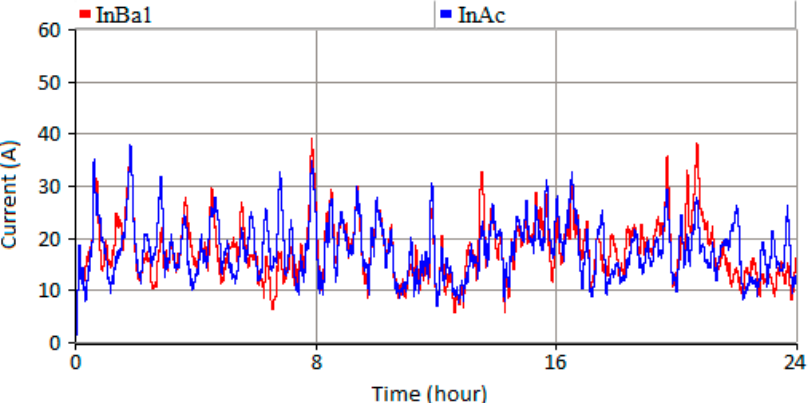
Figure 19. NCC under communication delay for case Ba-Time against case Ac.